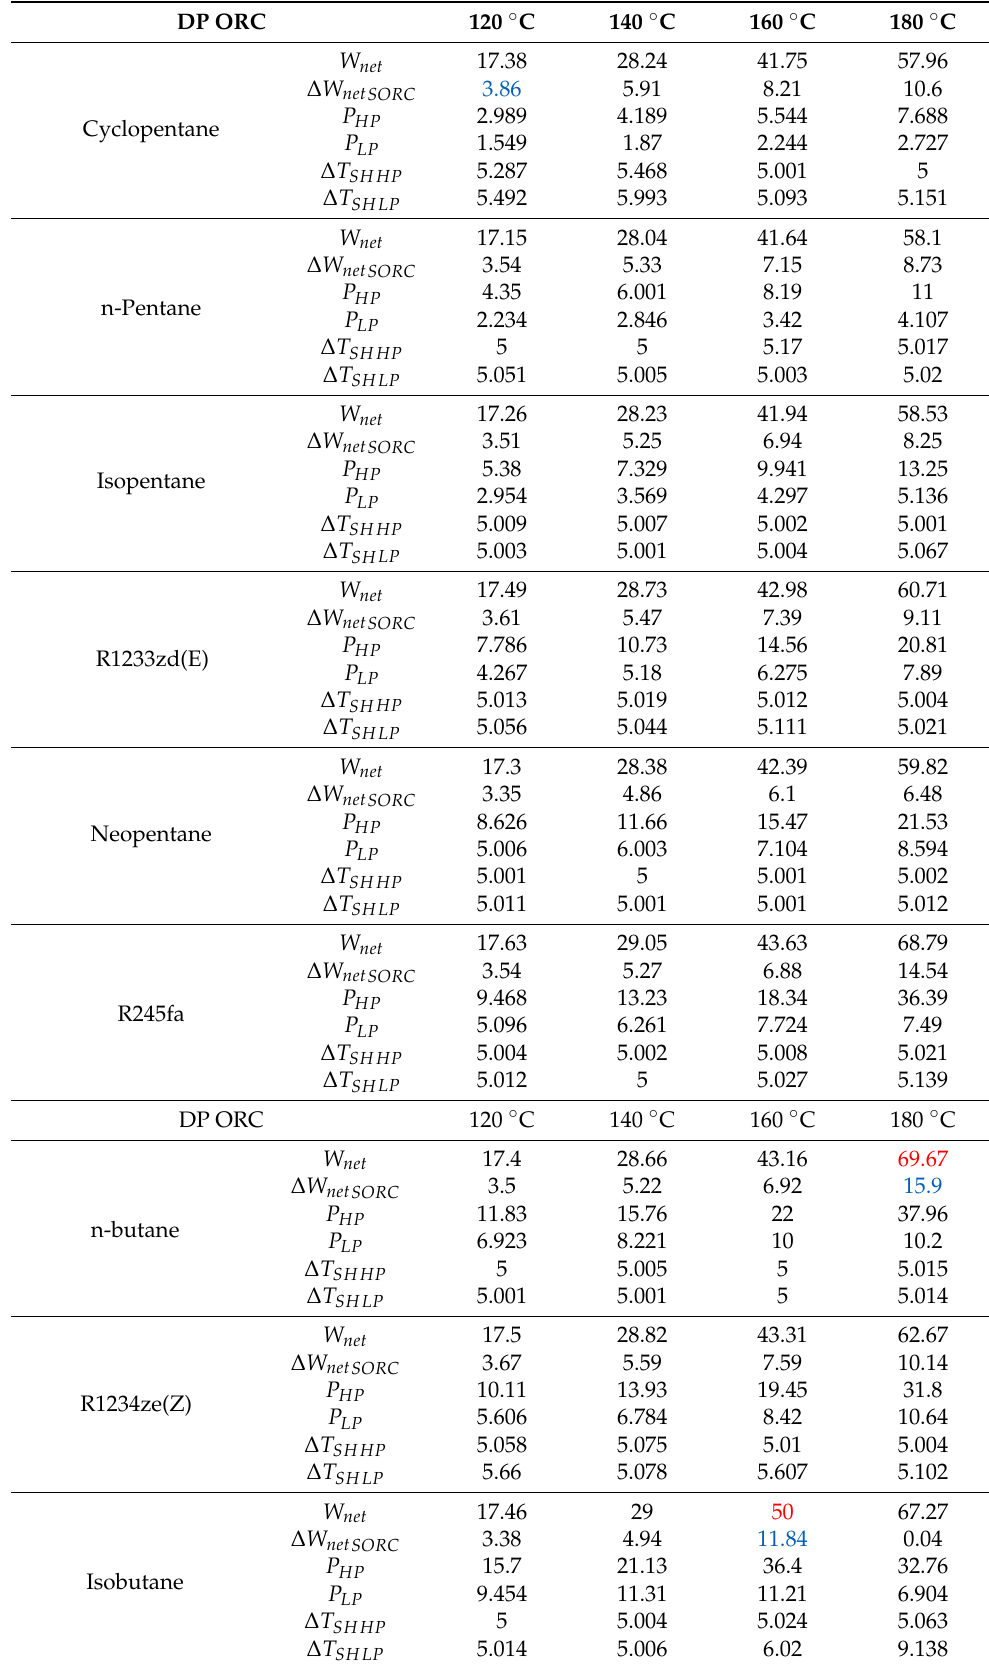
Table A6. The obtained results of the net power optimization for the DP ORC